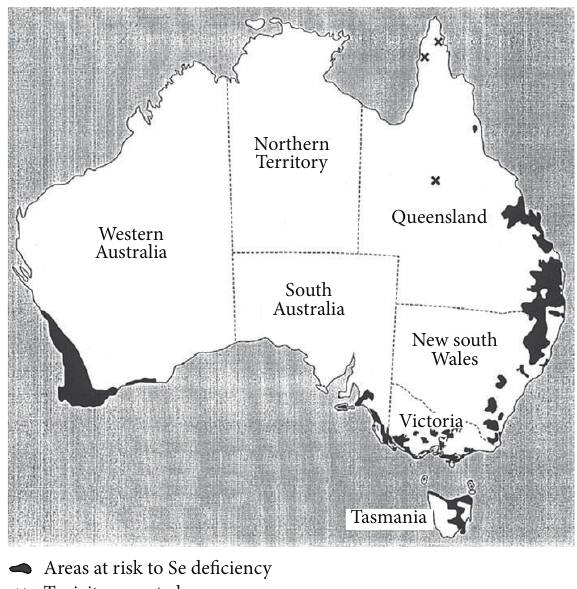
Figure 2: Map of Australia showing potential areas where livestock may be at risk for selenium deficiency or toxicity (extracted from